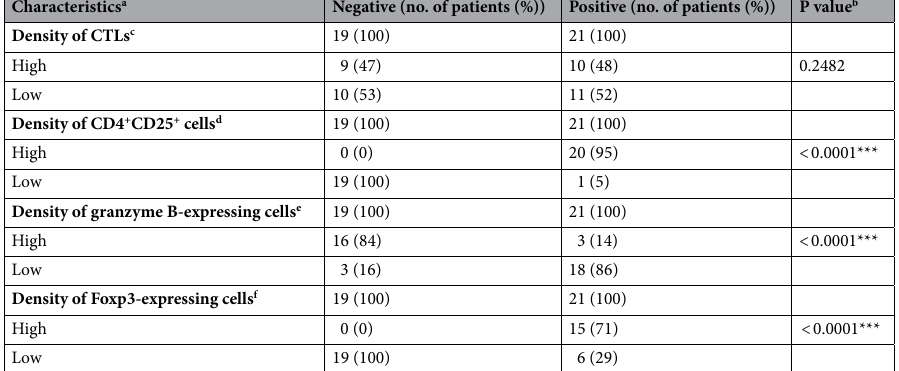
Table 1. Clinicopathological correlation of the deletion spanning pre-S2 gene segment in 40 HBV-related HCC patients. HBV hepatitis B virus, HCC hepatocellular carcinoma, CTLs cytotoxic T lymphocytes, Foxp3 forkhead box P3, HBeAg hepatitis B e antigen, AST aspartate aminotransferase, ALT alanine aminotransferase, AFP alpha-fetoprotein, CLIP Cancer of the Liver Italian Program, BCLC Barcelona Clinic Liver Cancer, AJCC American Joint Committee on Cancer, TNM tumor-node-metastasis. ***P value < 0.001. a Only patients with